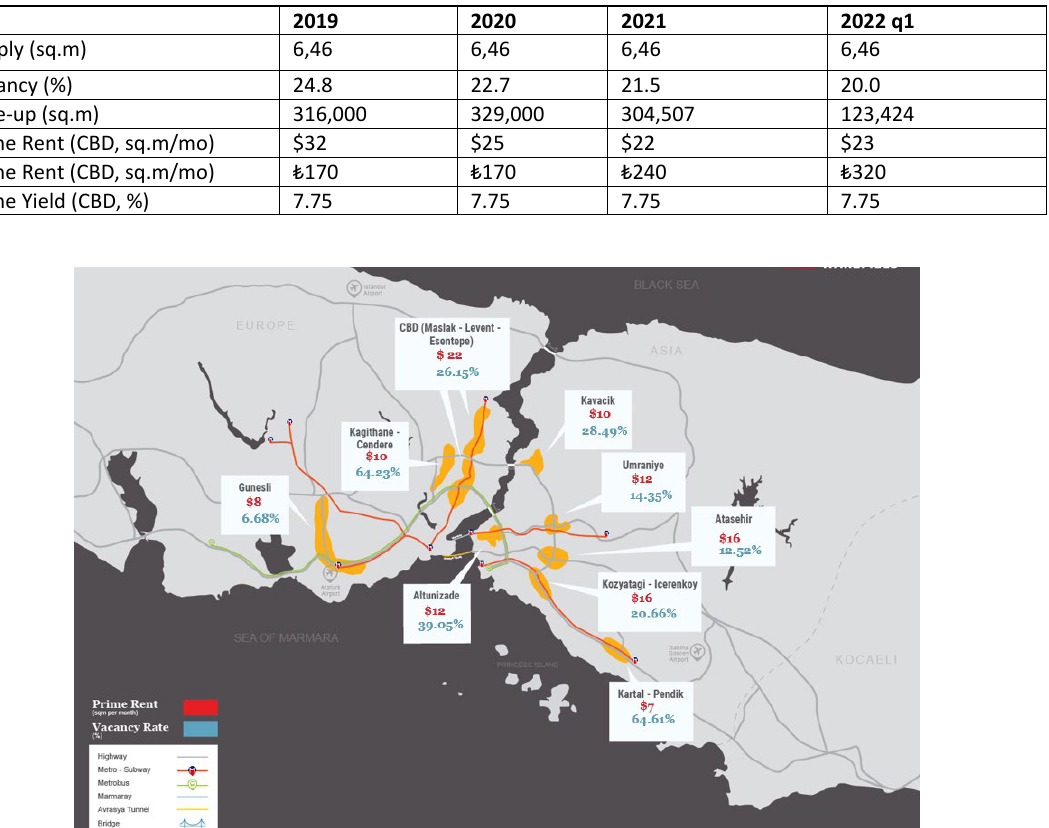
Table 3 Istanbul Office Market Summary (Cushman&Wakefield, 2022)